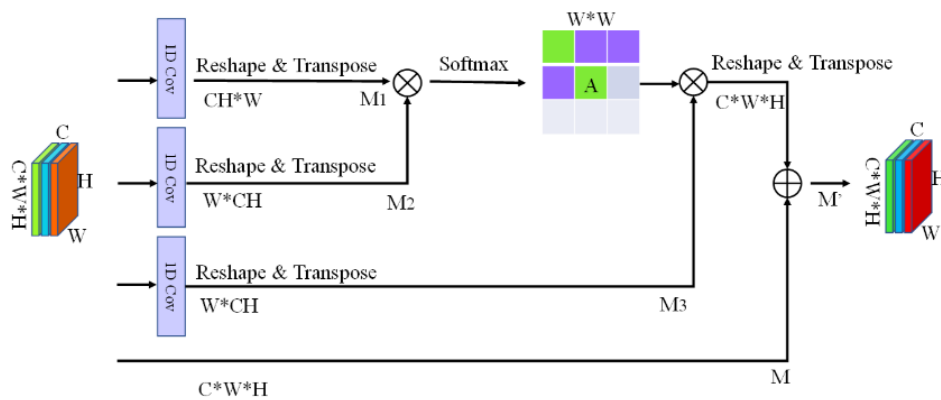
Figure 4. Row-based attention module.